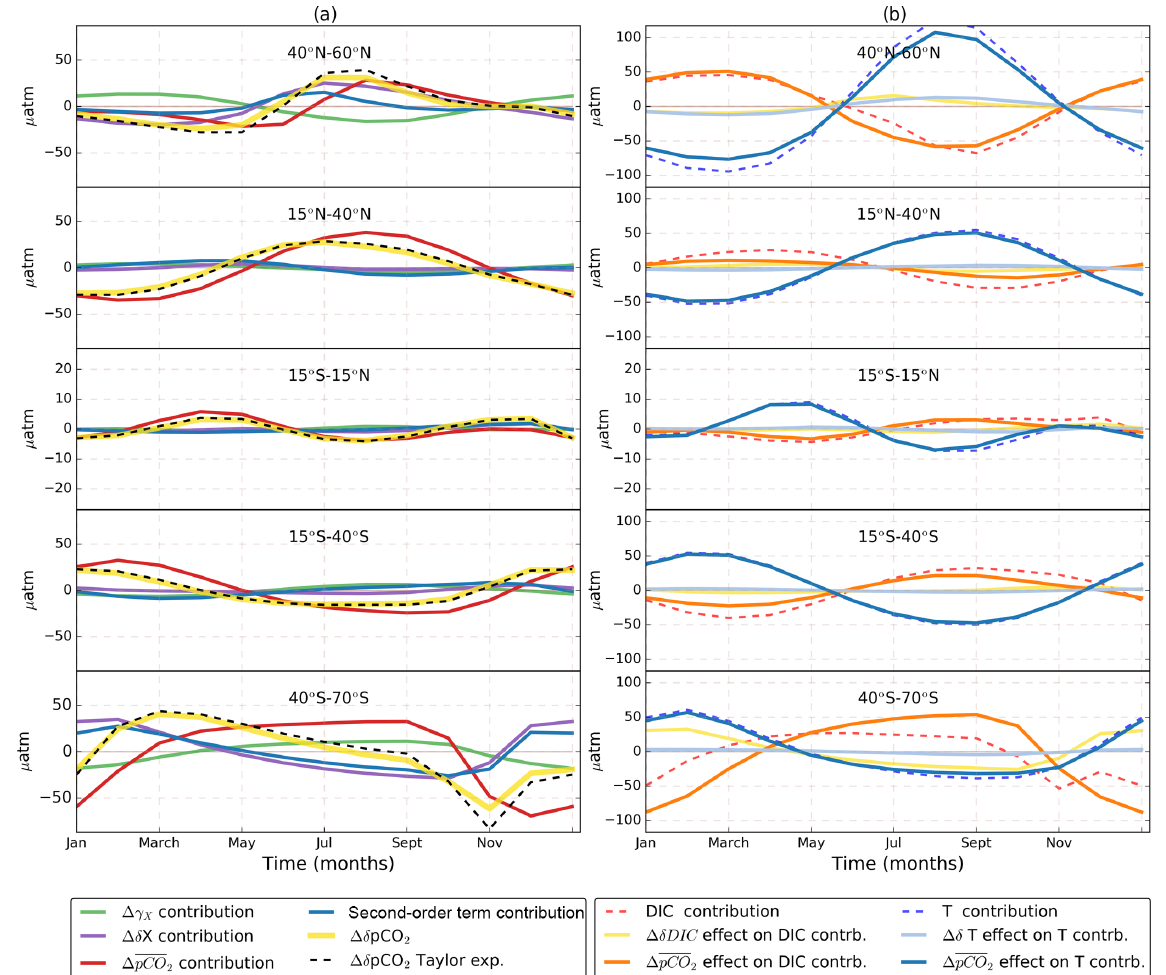
Figure 6. Contribution of seasonalities, sensitivities, and mean p CO 2 changes to (cid:49)δp CO 2 . (a) Time series for the terms of Eq. (6) for different latitudinal bands. The (cid:49) symbol represents the total century change calculated as the 2080–2100 value minus the 2006–2026 value. The total change in seasonal p CO 2 ( (cid:49)δp CO 2 ) is depicted as a dashed black. This change is decomposed into changes in seasonalities ( (cid:49)δ X , purple), sensitivities ( (cid:49)γ X , green), mean p CO 2 ( (cid:49)p CO 2 , red), and second-order terms (blue) summed over the four variables that control p CO 2 (DIC, TA, T and S ). For comparison with the expansion, (cid:49)δp CO 2 is calculated from model output (yellow). Column (b) shows the total change in DIC (dashed red) and T (dashed blue) contributions. Also shown are two components of the total change in these contributions: the (cid:49)p CO 2 effect on the DIC (solid orange) and T (solid blue) contributions and the (cid:49)δ DIC (yellow) and (cid:49)δT (light blue) effects. In column (a) , the δp CO 2 change follows the (cid:49)p CO 2 effect. Column (b) shows that, actually, the leading cause of amplification is the (cid:49)p CO 2 effect on the T contribution. It is important note the different scale between column (a) and (b) . Also, the scale was reduced in the 15 ◦ S–15 ◦ N region to highlight its